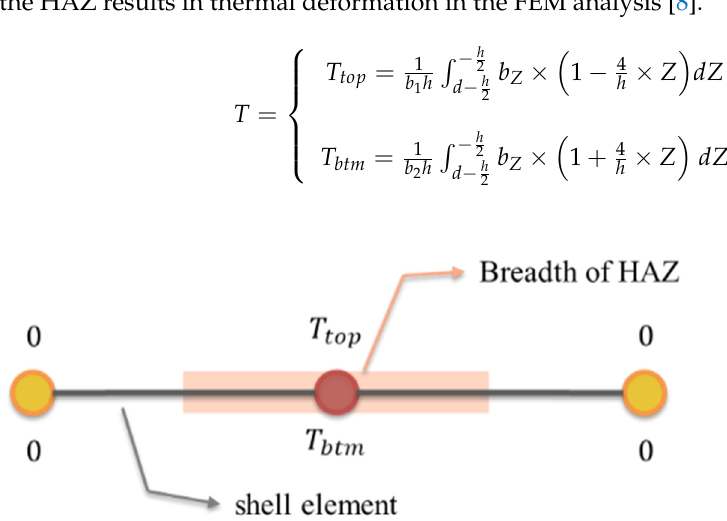
Figure 6. Temperature boundary conditions imposed on the shell element.